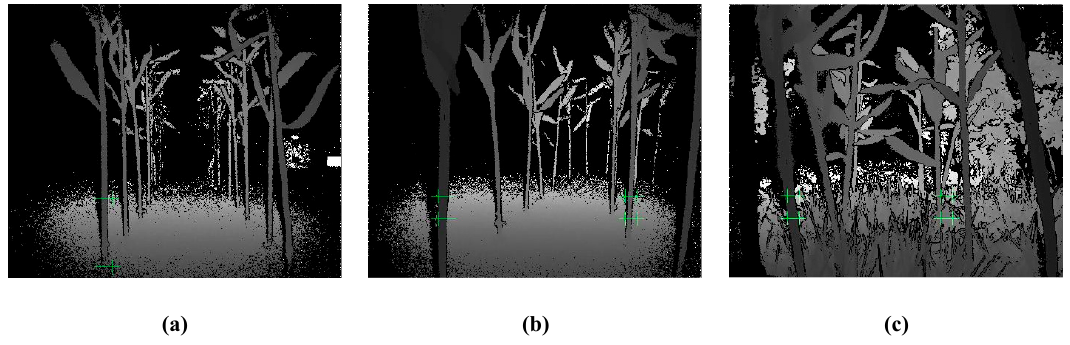
Figure 18. Camera recognition depth map. (a) ground straight line; (b) ground curve; (c) field straight line.